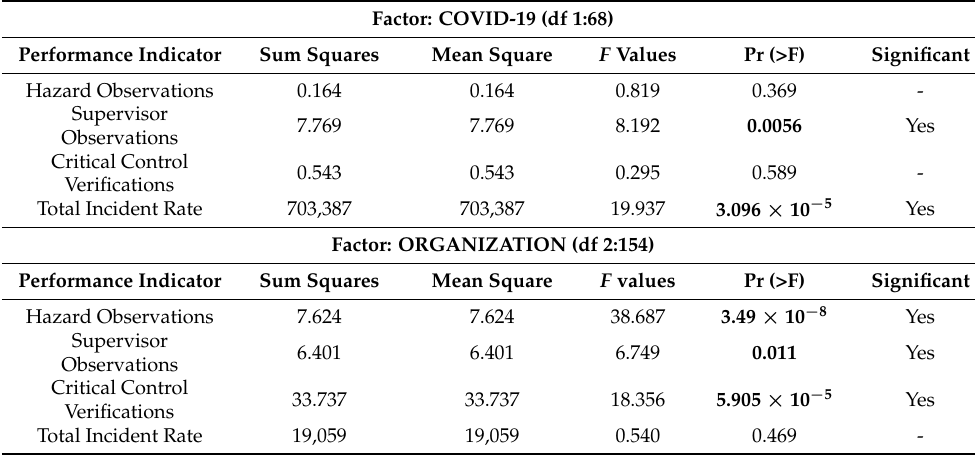
Table 9. Safety Performance for COVID and LEADER Factors–ANOVA Results. Factor: COVID-19 (df